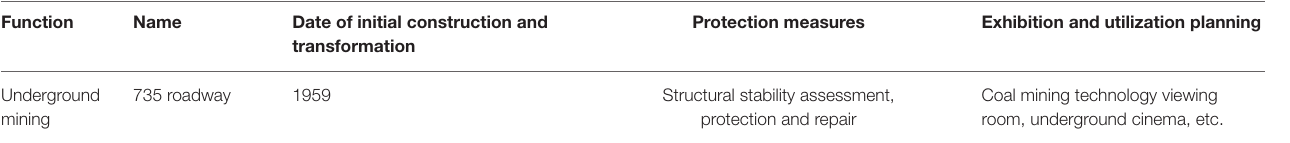
TABLE 2 | Overview of Wangshiwa underground